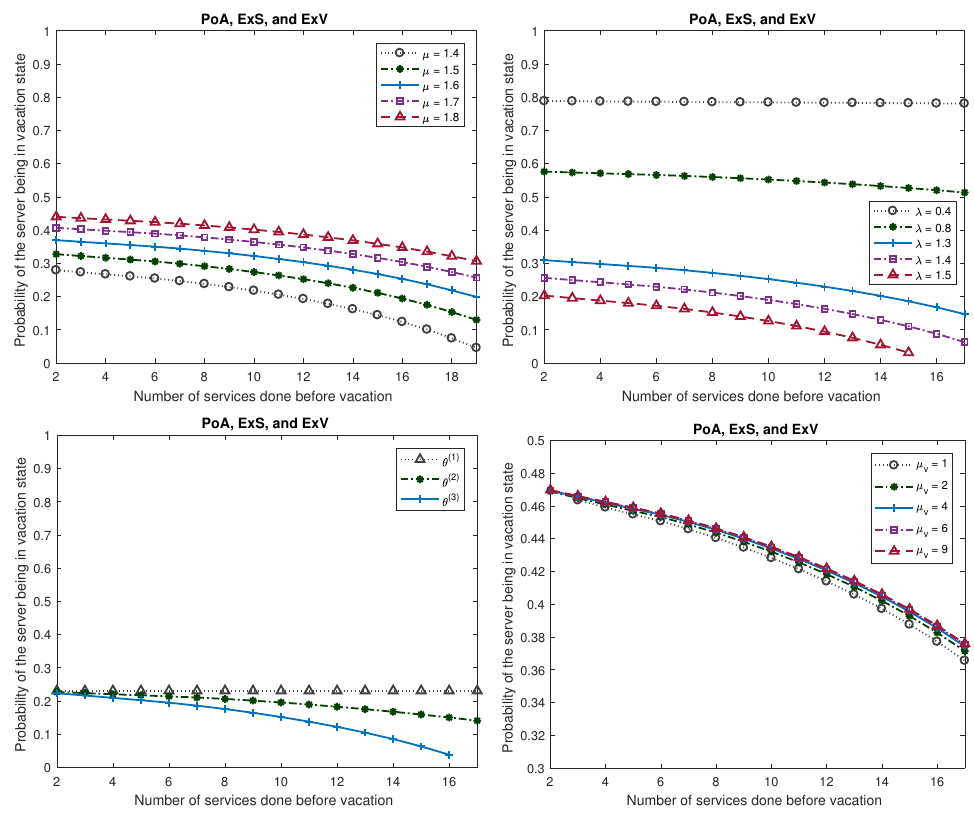
Figure 8. Probability of the server being in vacation state (Model 2).